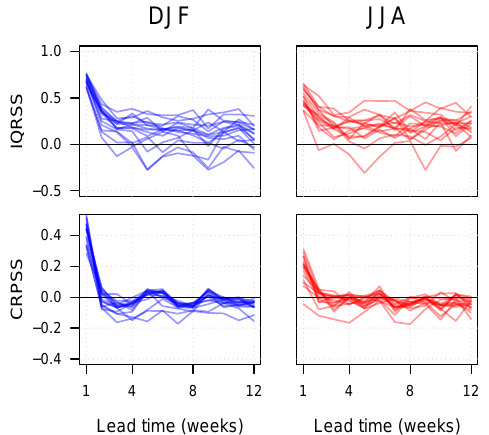
Figure 2. Skill of raw weekly precipitation forecasts as a function of the lead time for all catchments and for the winter (DJF) and summer (JJA) seasons. The skill is computed based on the IQR (top) and the CRPS (bottom) and the reference is historical precipitation. Each column corresponds to a target season. Each line represents the skill score in a catchment for forecast horizons within the target